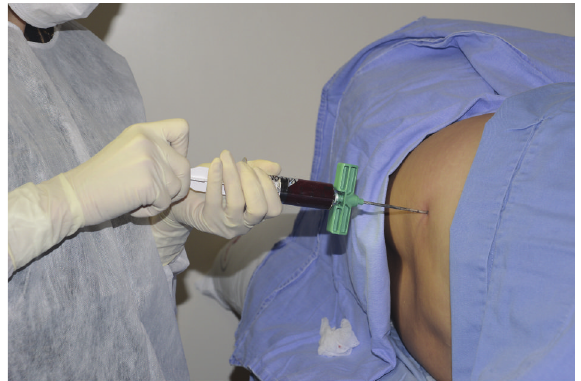
Figure 2: Bone marrow was collected from all the patients by aspiration through a puncture 2cm laterocaudally from the superior posterior iliac crest.